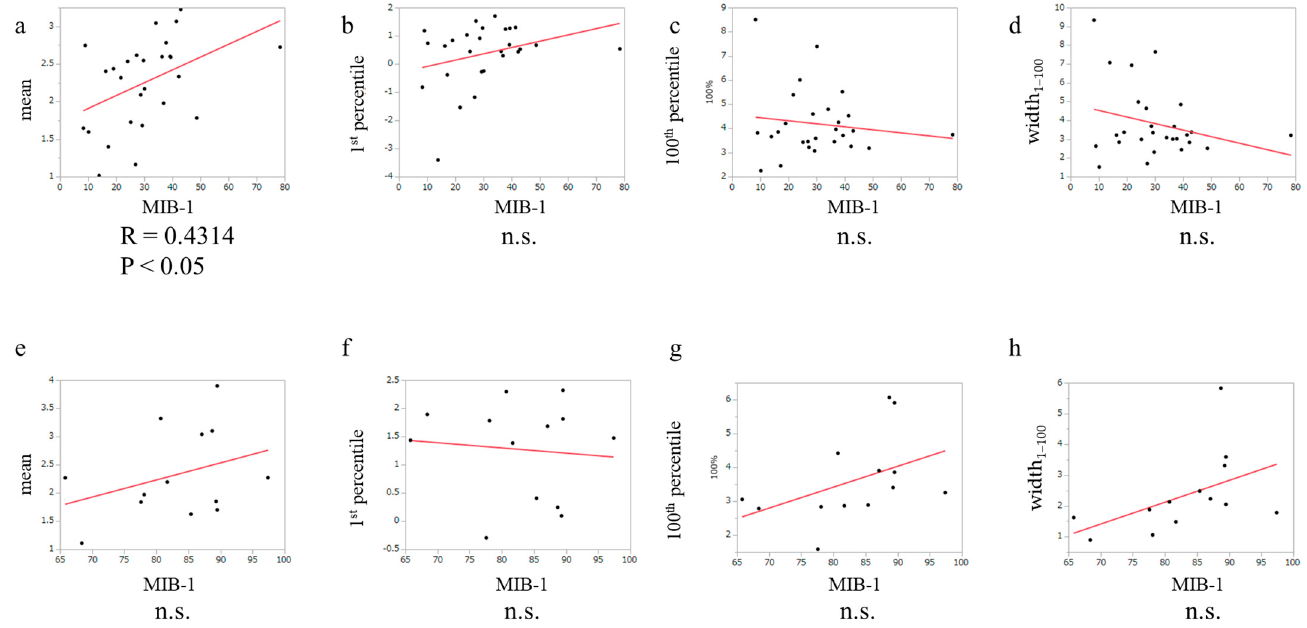
Figure 4. The correlation between the MIB1 index and the mean, 1st percentile, 100th percentile, and width 1–100 APTw signals of ( a – d ) glioblastoma, IDH-wildtype and ( e – h ) PCNSL. Table 3. The subtype and MIB-1 index of predictable and unpredictable PCNSLs. Predictable Unpredictable